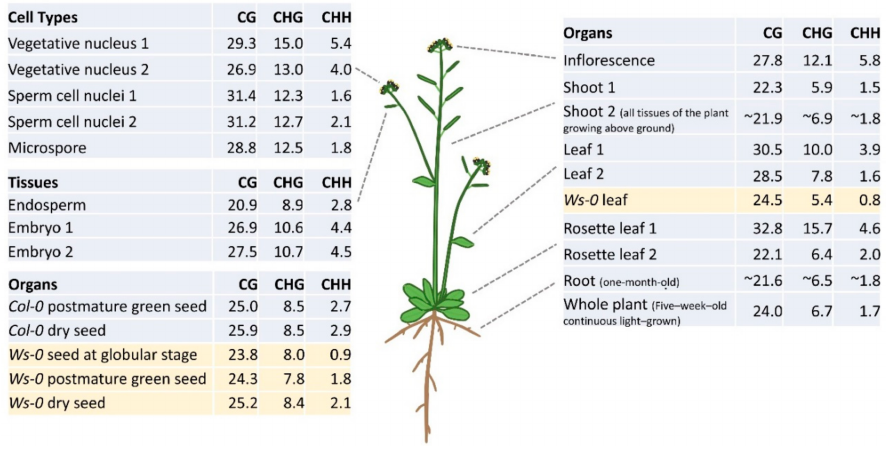
Figure 2. DNA methylation levels in different organs, tissues, and cells in Arabidopsis . Organs, tissues, or cell types were collected from wild type Col-0 (Columbia) except the organs indicated as Ws-0 , referring to Wassilewskija. Organs, tissues, cells, and methylation data were from references listed below: vegetative nucleus 1, sperm cell nuclei 1, microspore, embryo 2, and inflorescence [61]; vegetative nucleus 2 and sperm cell nuclei 2 [62]; endosperm and embryo 1 [55]; postmature green seed, dry seed, leaf 2, Ws-0 seed and leaf [63]; leaf 1 [41]; rosette leaf 1 [64]; Rosette leaf 2 [65]; shoot 1 [45]; shoot 2 and root [53]; whole plant [66]. The methylation data were from different studies that might have some technical variations among different experiments, but procedures and technologies (genomic library construction, bisulfite conversion and efficiency, and next-generation sequencing) used were similar, thus overall results can be